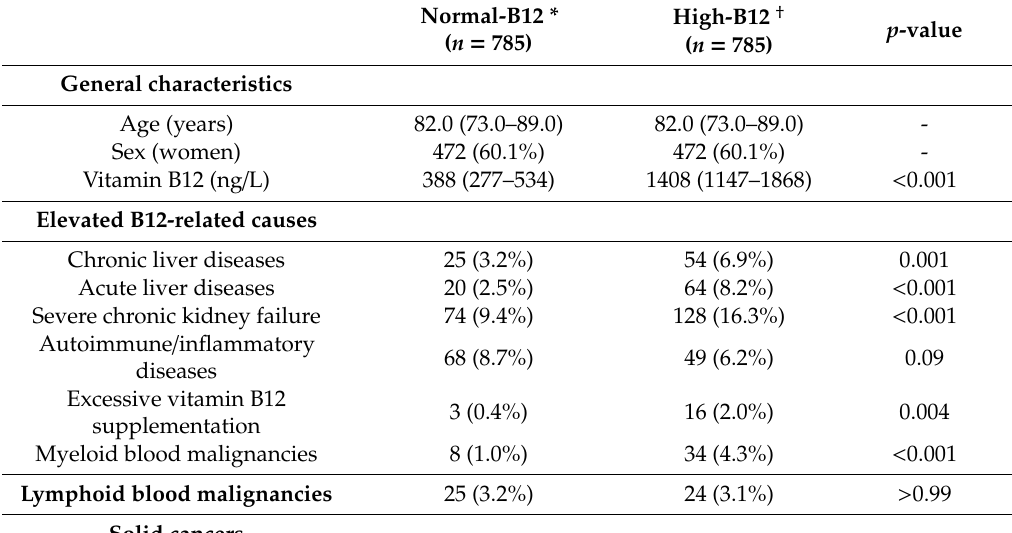
Table 1. Comparison of Normal-B12 and High-B12